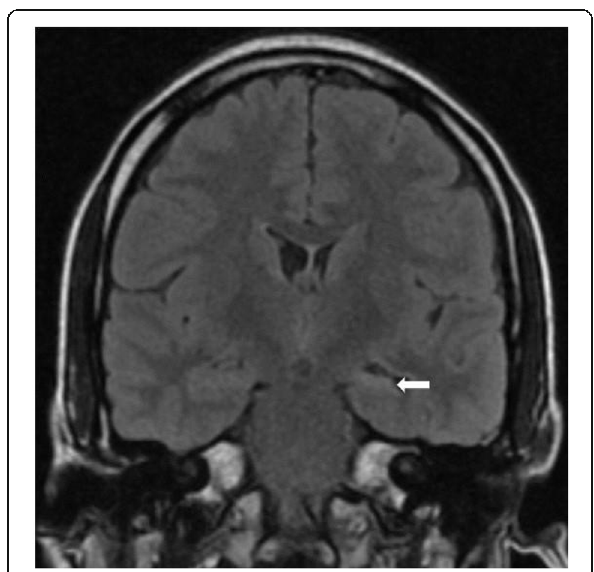
Fig. 2 Coronal T2 fluid-attenuated inversion recovery sequence MRI of the brain showing left hippocampal sclerosis (white arrow)